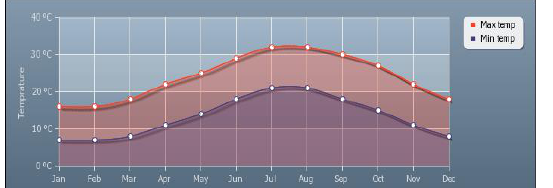
Figure 1. Average minimum and maximum temperatures for Famagusta over the year (retrieved from url1, 01thapril,